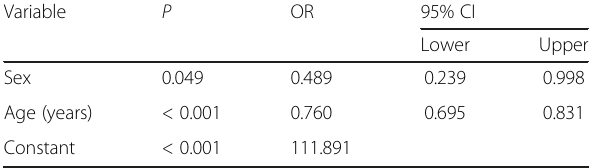
Table 4 Results of the logistic regression model with the maturational stages of the midpalatal suture as outcome variable and age and sex as predictors Variable